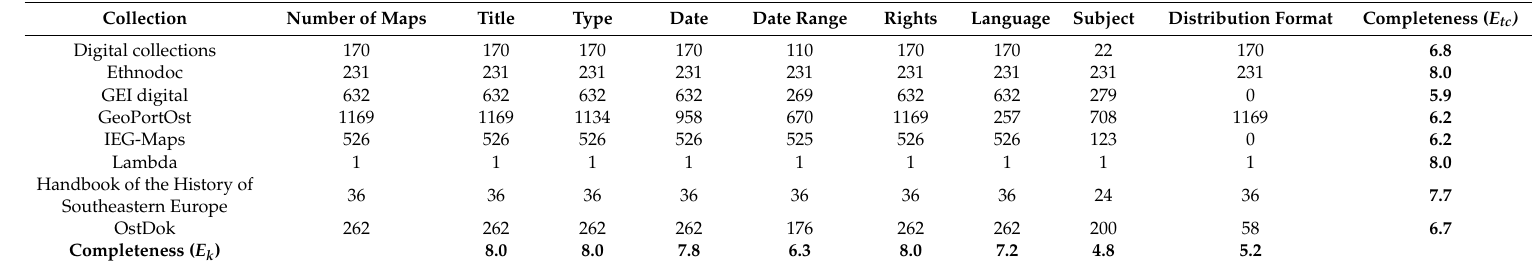
Table 4. Number of objects that have data for typical evaluation criteria ( m c ).